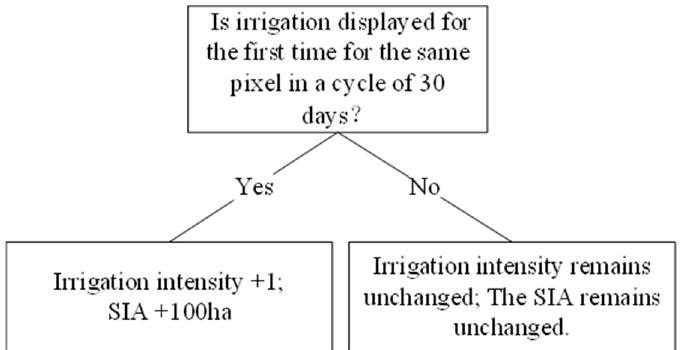
Figure 5. Decision tree for calculating the SIA and irrigation intensity.